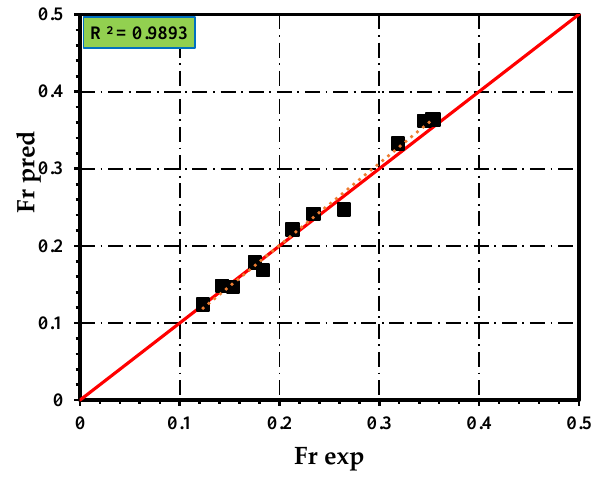
Figure 12 SRM-predicted coefficient of friction versus experimental results.